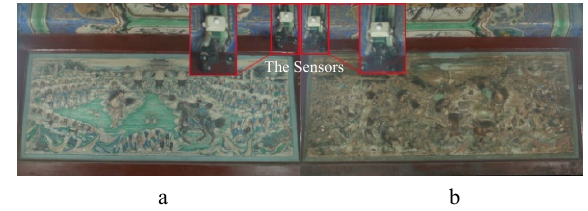
Figure 1. The east painting (a) and the west painting(b)